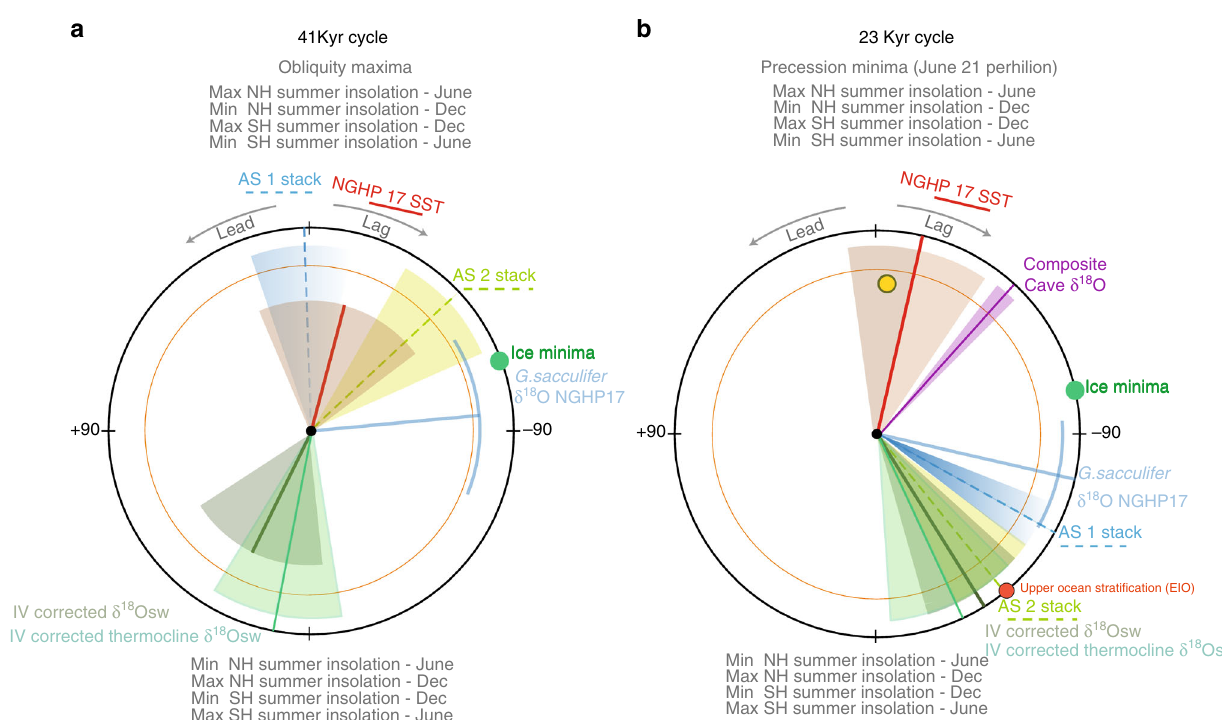
Fig. 4 Phase wheels illustrating Asian monsoon response to orbital forcing. a Obliquity (41 kyr) and b precession (23 kyr) phasing of Asian monsoon proxy records during the late Quaternary. The precession index is de fi ned as Δ ε sin ω , where ω is the longitude of the perihelion measured from the moving vernal point and ε is the eccentricity of Earth ’ s orbit around the Sun 52,53 . Obliquity is the axial tilt of Earth ’ s rotation axis with respect to the orbital plane. In the phase wheel representation, the 12 o ’ clock position is set to precession minima ( P min; ω = 90°, 21st June perihelion) and obliquity maxima ( O max), respectively. Negative/positive phases are measured in the clockwise/anticlockwise direction and represent phase lags/leads relative to P min or O max. Published records plotted (with shaded phase estimate errors) are the Arabian Sea summer monsoon stacks AS1 (ref. 10 ) and AS2 (ref. 9 ), composite cave δ 18 O records from southwest 15 (shown in yellow circle) and east China 19 , upper ocean strati fi cation record from the eastern Indian Ocean (EIO) 13 and IV- corrected δ 18 Osw records from NGHP 17 (this study). Orange circle denotes 80% coherency The 95% and 80% con fi dence intervals for coherency are 0.79 and 0.64 with bandwidth 0.00423175. The interpolated time interval is 3.5 kyrs and covers 3 to 951 kyrs. Phase errors for the IV-corrected mixed layer and thermocline δ 18 Osw records at the precession band are ± 17° and± 20°, respectively. Phase errors for the IV-corrected mixed layer and thermocline δ 18 Osw records at the obliquity band are ± 36° and ± 20°,